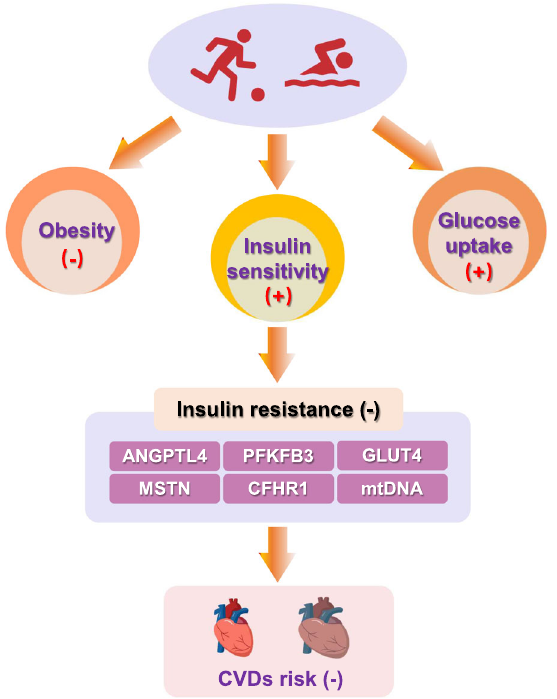
Fig. 7 The effects of exercise on insulin resistance and transcrip- tional changes. Exercise improves insulin resistance via reducing obesity, improving insulin sensitivity, and glucose